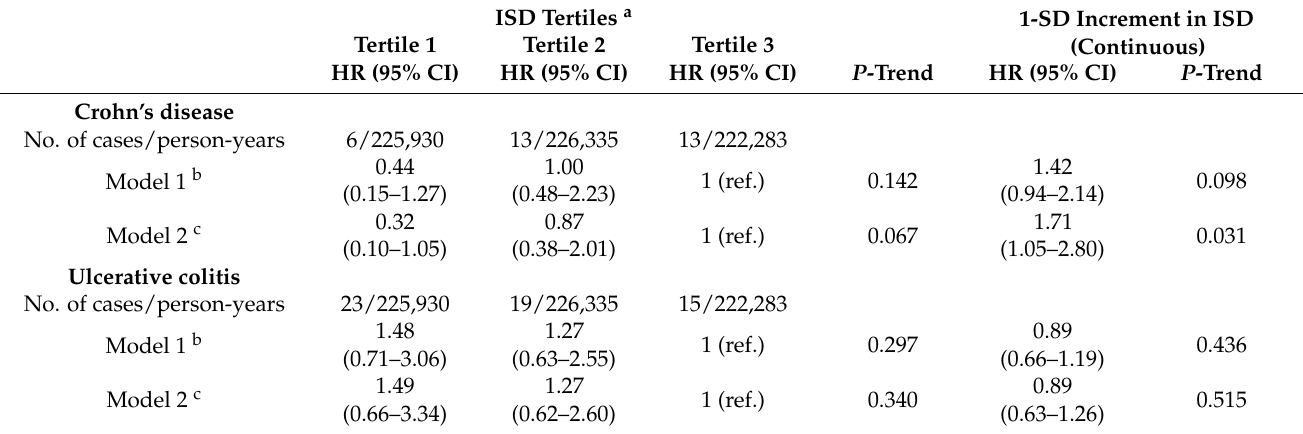
Table 2. Association of the Inflammatory Score of the Diet (ISD) with incidence of Crohn’s disease and ulcerative colitis. ISD Tertiles a 1-SD Increment in ISD